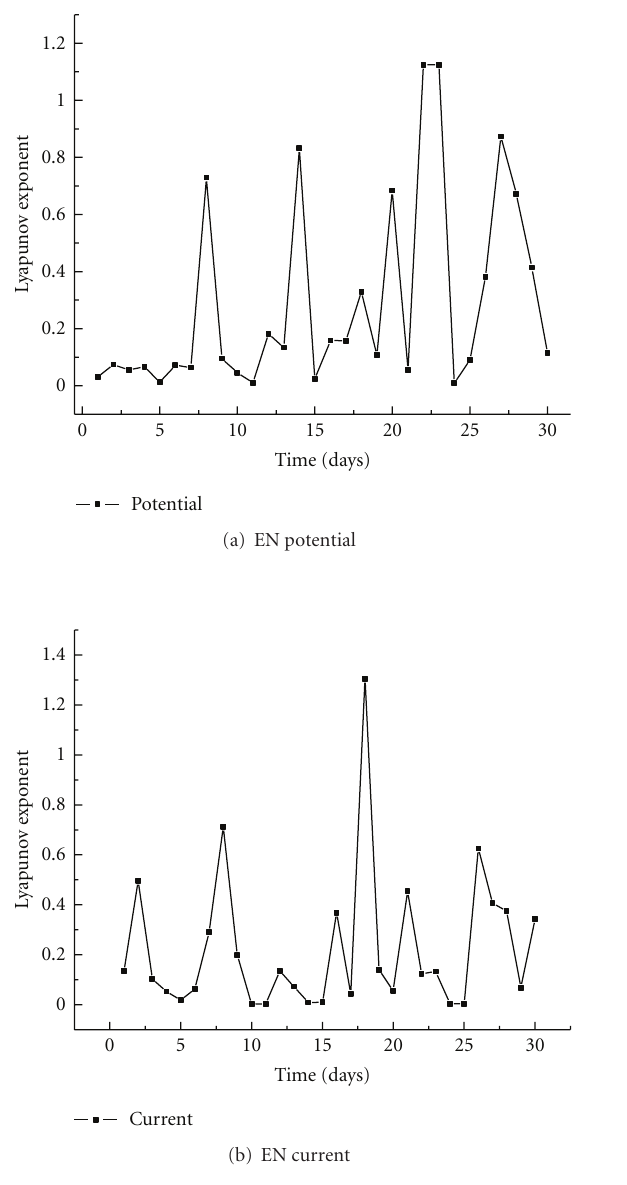
Figure 7: Lyapunov exponents for EN time series as a function of time.